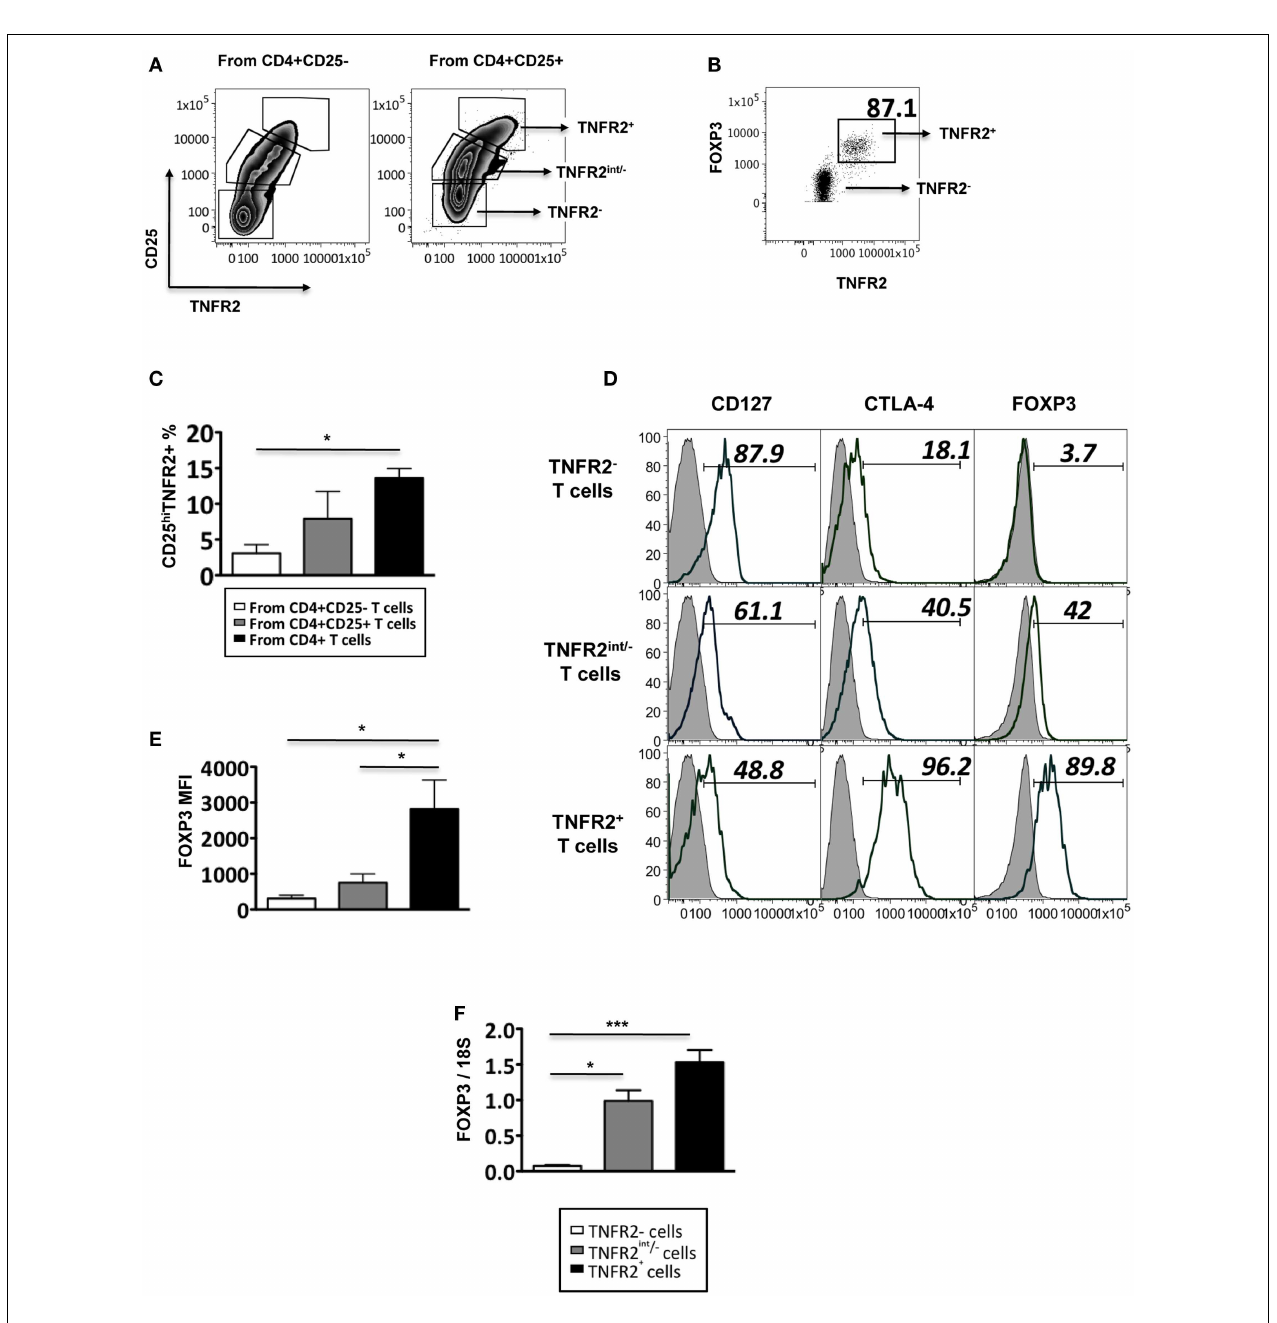
histograms represent isotype staining while clear histogram represents the indicated molecule.The numbers indicate percentage positive for the represented molecular marker. (E) The MFI of FOXP3 within theTNFR2 subsets. (F) The mRNA expression levels of FOXP3 within theTNFR2 subsets. Data shown in (A,B,D) are representative of four donors respectively while (C,E,F) are summarized from four donors. Kruskal–Wallis with Dunn’s multiple comparison test was used here and graphs represent mean ± SEM. * p <